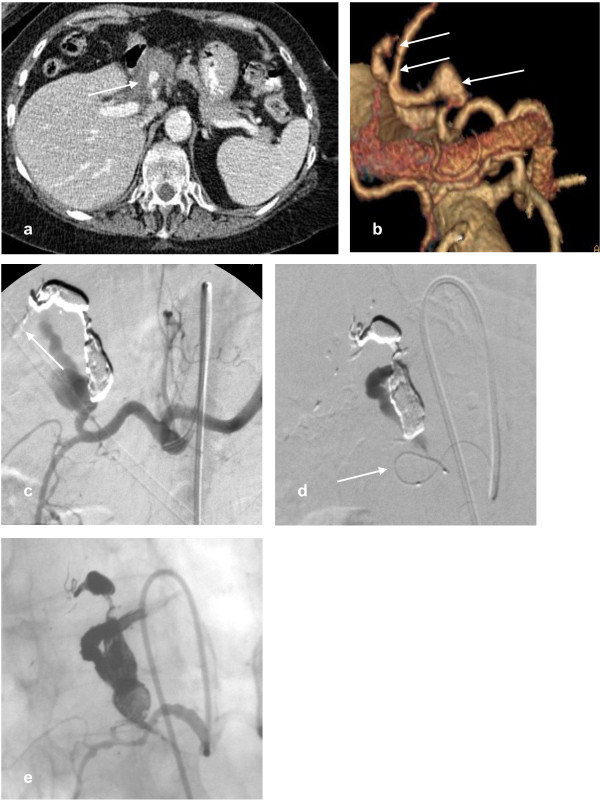
a) A patient with vasculitic hepatic artery aneurysms presented following minor trauma. Axial contrast enhanced CT demonstrates haematoma around a pseudoaneurysm (arrow) indicating that this is the likely cause of recent haemodynamic instability. b) 3D volume rendered reconstruction demonstrates 3 aneurysms arising from a branch of the left hepatic artery (arrows). The right hepatic artery arose from the SMA. c) Selective arteriogram of the coeliac axis with standard catheter after 2 aneurysms had been embolised with onyx (ev3, Irvine, CA, USA). The cast of the onyx is demonstrated, and some distal embolisation (arrow) of onyx. d) A microcatheter is demonstrated within the final bleeding aneurysm (arrow). e) A selective angiogram demonstrates onyx filling all aneurysms and maintained patency of the gastroduodenal artery.